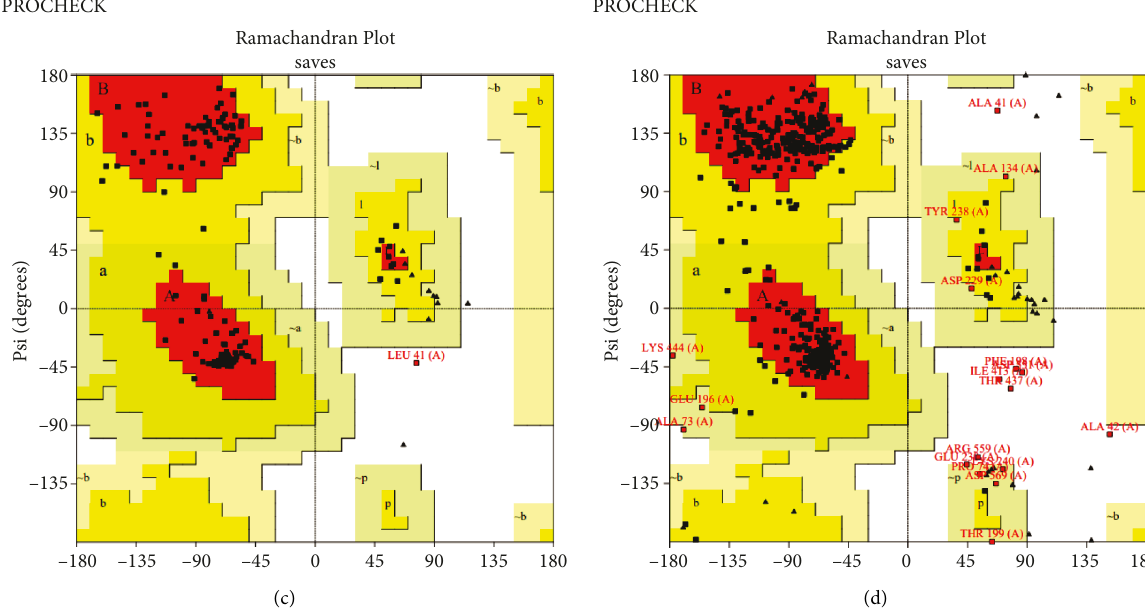
Figure 3: Ramachandran plot of (a) VP1; (b) VP2; (c) P48; and (d) P22 proteins.